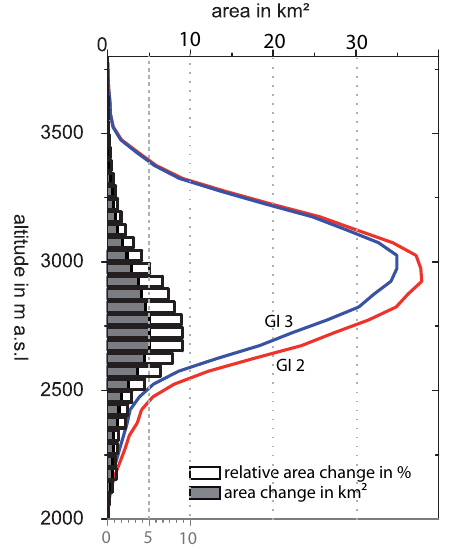
Figure 11. Altitudinal distribution of areas in GI 2 and GI 3 with absolute and relative area